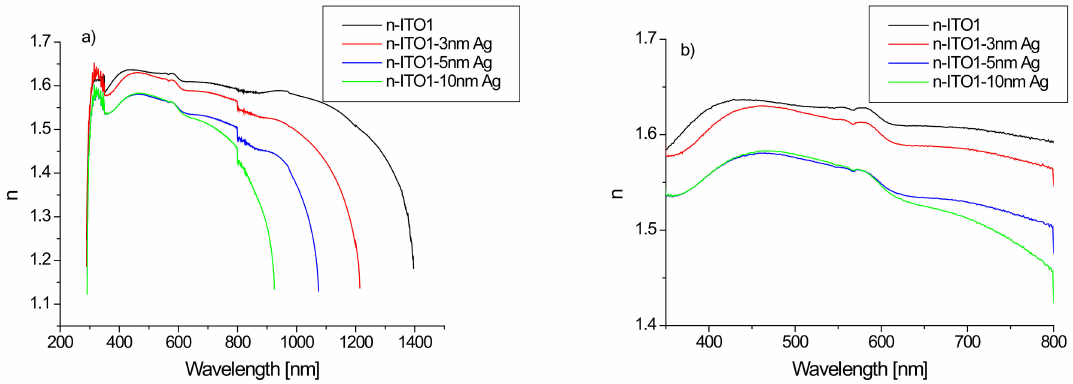
Figure 7. Dependence of the refractive index on the wavelength of the layer based on ITO1, for the range 200–2500 nm ( a ) and the visible region ( b ).